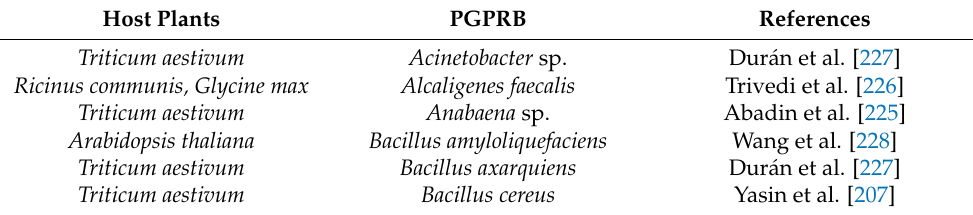
Table 7. Plant growth-promoting rhizobacteria (PGPR) which facilitate the uptake of Se. Host Plants PGPRB Triticum aestivum Acinetobacter sp. Dur á n et al. [227] Ricinus communis, Glycine max Alcaligenes faecalis Trivedi et al. [226] Triticum aestivum Anabaena sp. Abadin et al. [225] Arabidopsis thaliana Bacillus amyloliquefaciens Wang et al. [228] Triticum aestivum Bacillus axarquiens Dur á n et al. [227] Triticum aestivum Bacillus cereus Yasin et al.